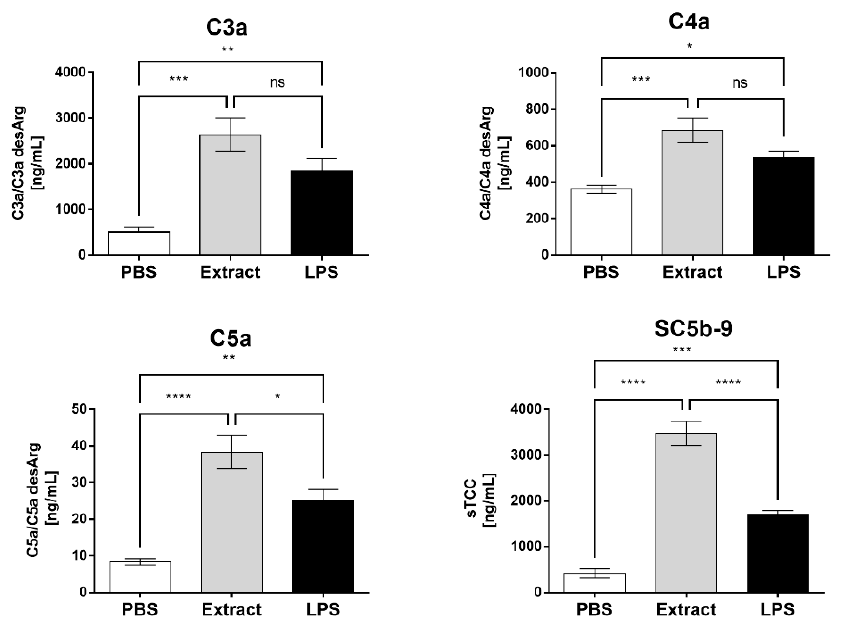
Figure 1. Production of anaphylatoxins and the terminal complement complex in whole blood stimu- lated with Pararama hair extract. Human blood samples anticoagulated with lepirudin (50 µ g/mL) were incubated with Pararama hair extract (95 µg/mL), LPS (5 µg/mL), or PBS for 30 min at 37 °C. After plasma collection, anaphylatoxin (C3a, C4a, and C5a) production was assessed by flow cy- tometry, and SC5b-9 was assessed by ELISA. The results are presented as the mean ± SD of three independent experiments. * p : < 0.05. ** p : < 0.01. *** p : < 0.001. **** p : < 0.0001. ns: not significant.